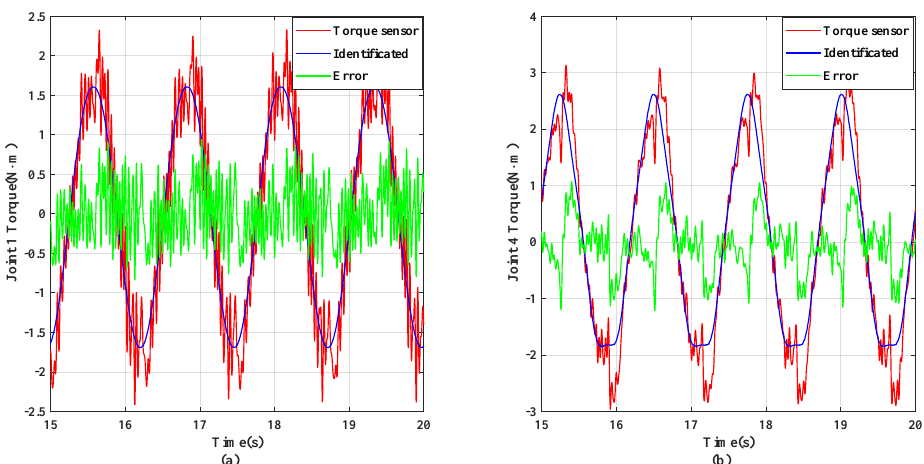
Figure 9. Identification and measurement of the actuator torques in the experiment. ( a ) Joint 1. ( b ) Joint 4.